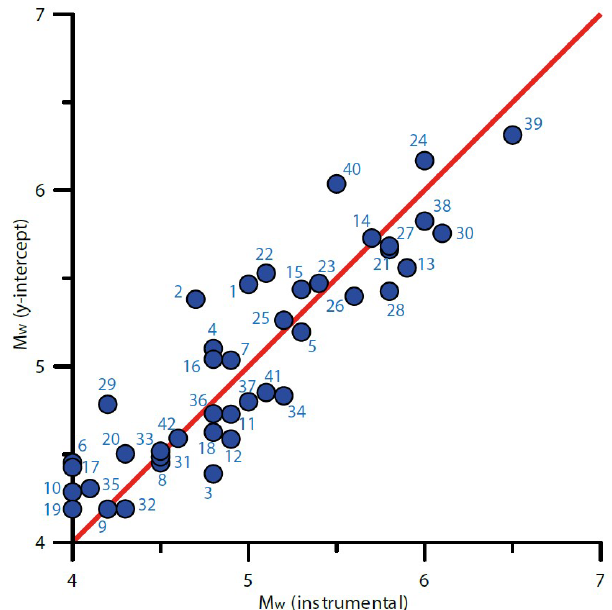
Figure 10. Correlation between the M w calculated with the y - intercept approach proposed in this work and the instrumental M w reported in Table 1 (Rovida et al., 2020) for all the events in the learning set. Earthquakes falling above or below the line exhibit a higher (up to + 0 . 61 magnitude units) or lower (up to − 0 . 41 magni- tude units) M w value,